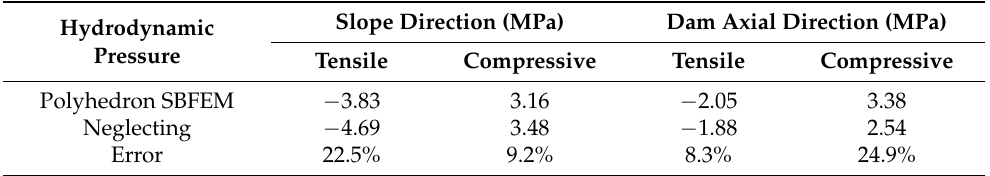
Table 4. Maximum dynamic stress of face slabs under an